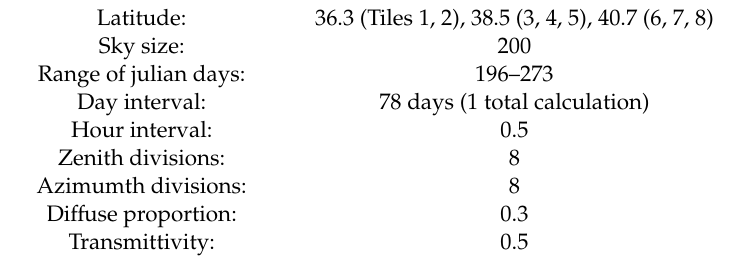
Table 2. Parameters for calculating solar radiation with ArcMap Points Solar Radiation function.